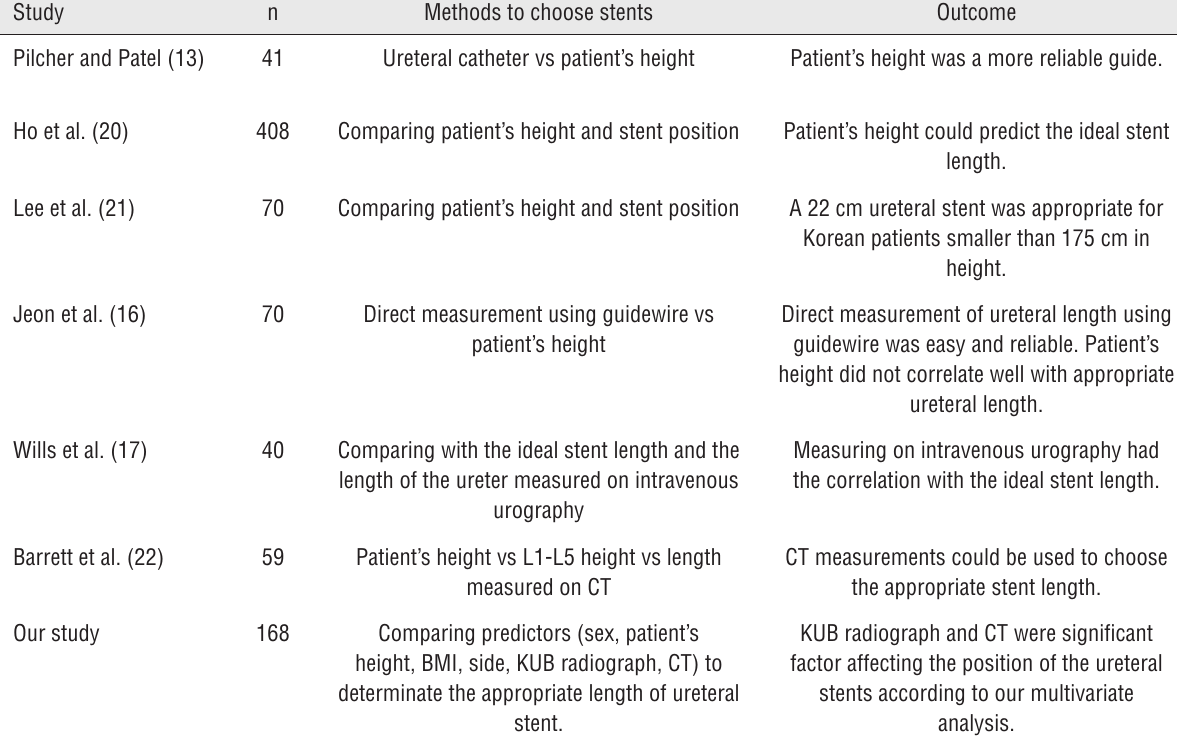
Table 3 - Clinical studies performed to choose the appropriate ureteral stent length that does not cross the bladder